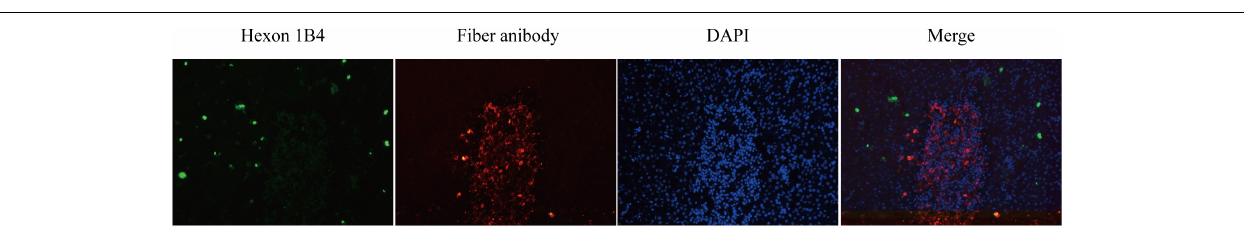
Frontiers in Microbiology |